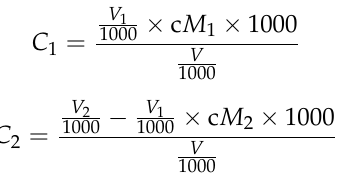
Table A1. The results of magnesium ions concentration in a sample.